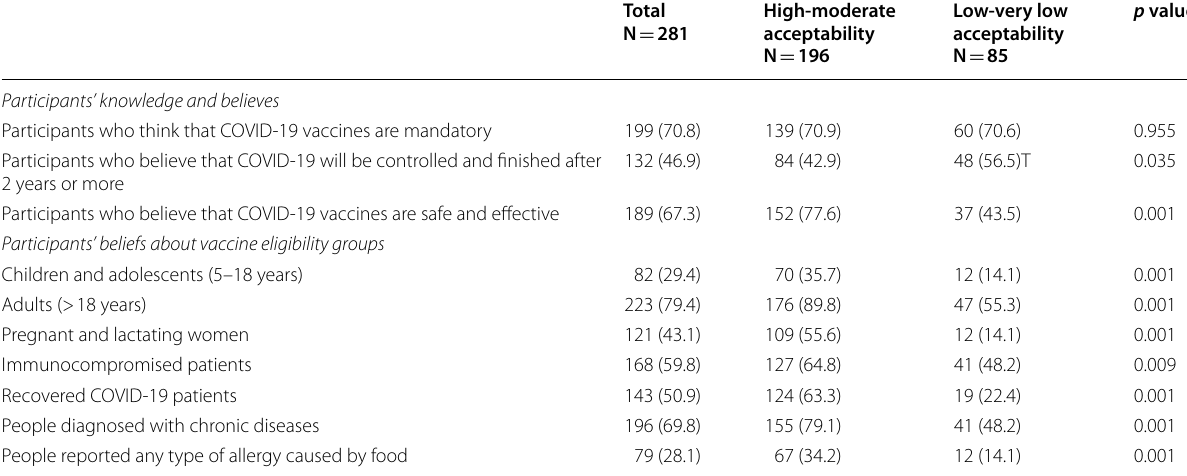
Table 3 The acceptance rate among studied participants relative to their knowledge and beliefs